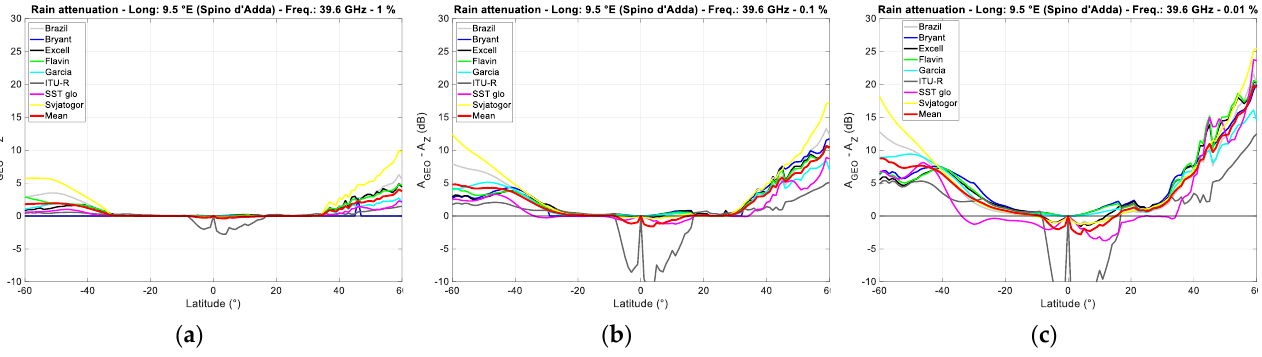
Figure 3. The difference 𝐴 𝐺𝐸𝑂 − 𝐴 𝑍 (dB), calculated at fixed annual probabilities 1% (a) 0.1% (b), and 0.01%, (c) between the rain attenuation exceeded in the GEO path, 𝐴 𝐺𝐸𝑂 (dB), and the rain attenuation exceeded in the GeoSurf path, 𝐴 𝑍 (dB), i.e., at the zenith in Spino d’Adda; 39.6 GHz, circular polarization.